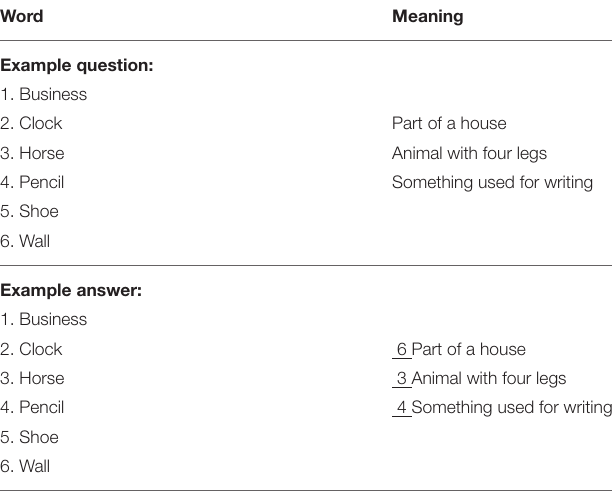
TABLE 1 | Example items in the Vocabulary Levels Test. Word Meaning